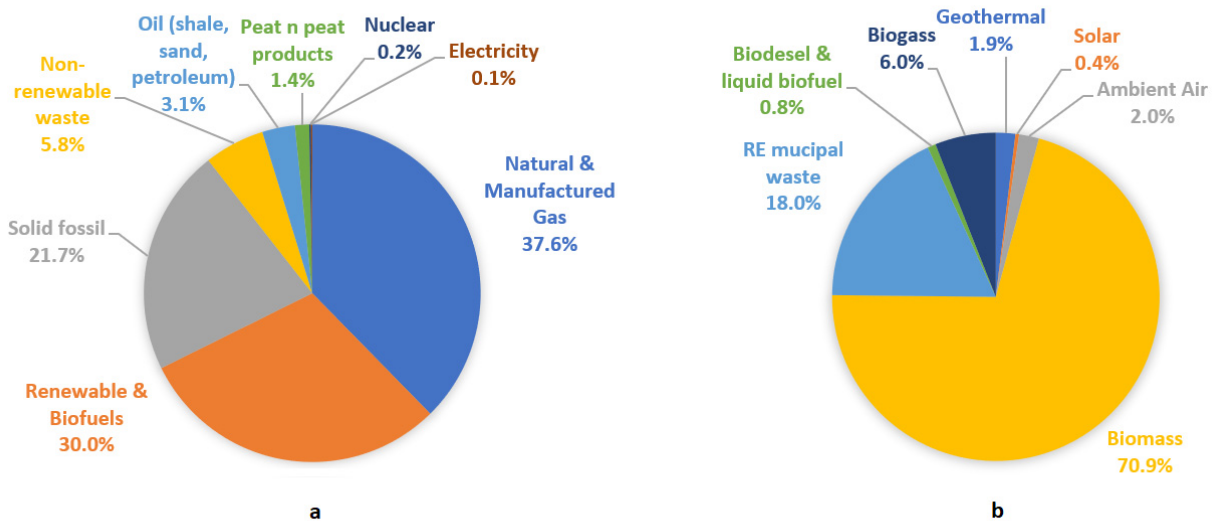
Figure 1. ( a ) Heating and cooling fuels, breakdown in EU@ Eurostat, 2019. ( b ) Renewable Heating and cooling, fuels breakdown in EU@ Eurostat, 2019.